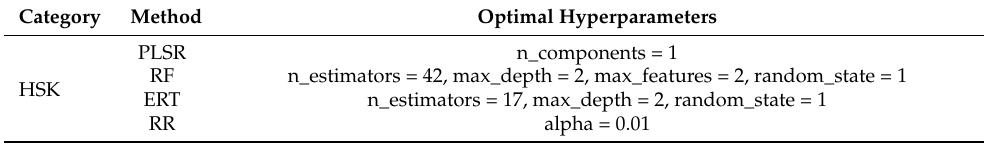
Table 3. Optimal hyperparameters of the machine learning methods based on hyperspectral